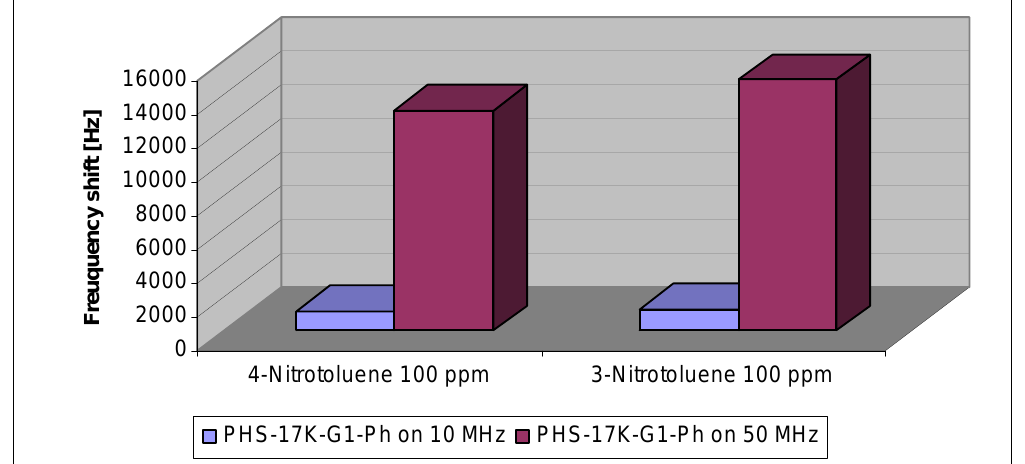
Figure 4. Frequency shift measured with 10 and 50 MHz